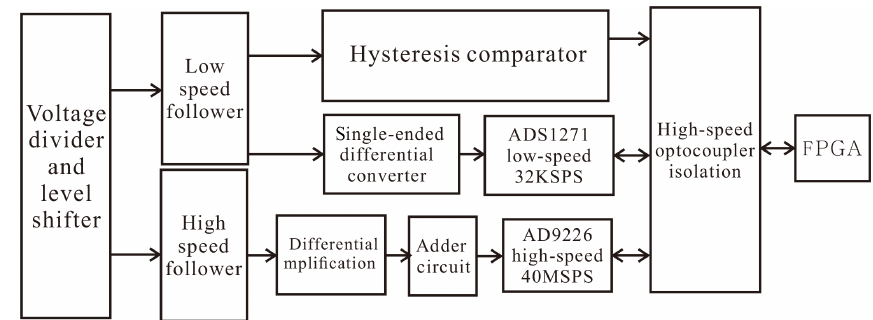
Figure 1. Block diagram of the conditioning process for voltage acquisition.